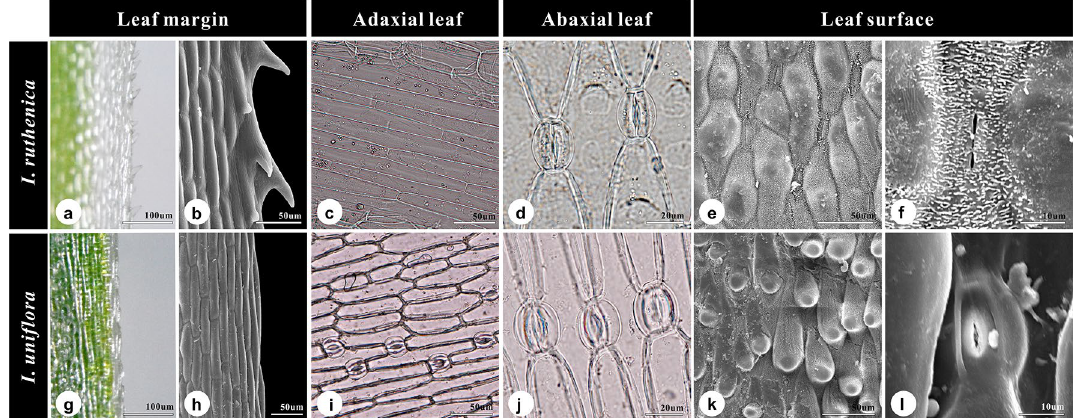
Figure 2. Stereo, light, and scanning micrographs of leaves of Iris ruthenica ( a – f ) and I. uniflora ( g – l ). Serrate ( a , b ) and entire ( g , h ) leaf margin. Hypostomatic (stomata is absent on adaxial surface but present on the abaxial surface of leaf) ( c , d ) and amphistomatic (stomata present on both adaxial and abaxial leaf epidermis) leaves ( i , j ) with anomocytic stomata. ( e , f , k , l ) Detailed leaf epidermal cell shape and sunken stomata on the leaf surface.